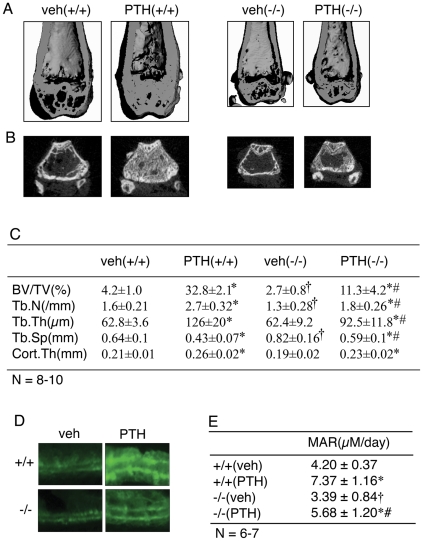
Effects of ATF4 deficiency on PTH stimulation in adult OVX bone.A, three-dimensional (3D) reconstruction from μCT scan of distal femurs of adult OVX mice. B, sagittal view of 2D distal femur at 1.7–2.0 mm from the chondro-osseous junction. C, BV/TV, Tb. N, Tb.Th, Tb.Sp, and Cort.Th. D, calcein double labeling of metaphyseal trabecular bone (magnification,x200). *P<0.05 (veh vs. PTH), † P<0.05 (wt-veh vs. Atf4−/−-veh), #P<0.05 (PTH/veh-wt vs. PTH/veh-Atf4−/−).